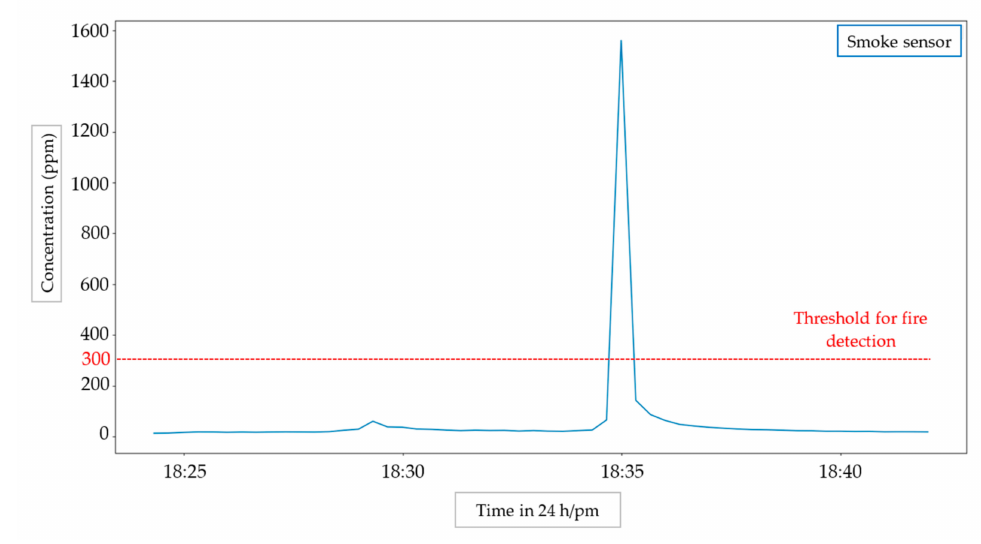
Figure 9. Concentration values for the smoke sensor before the event, during the event (time period from 18:34:00 to 18:35:50 24 h/pm), and after the event. The red line represents the threshold associated with fire detection.